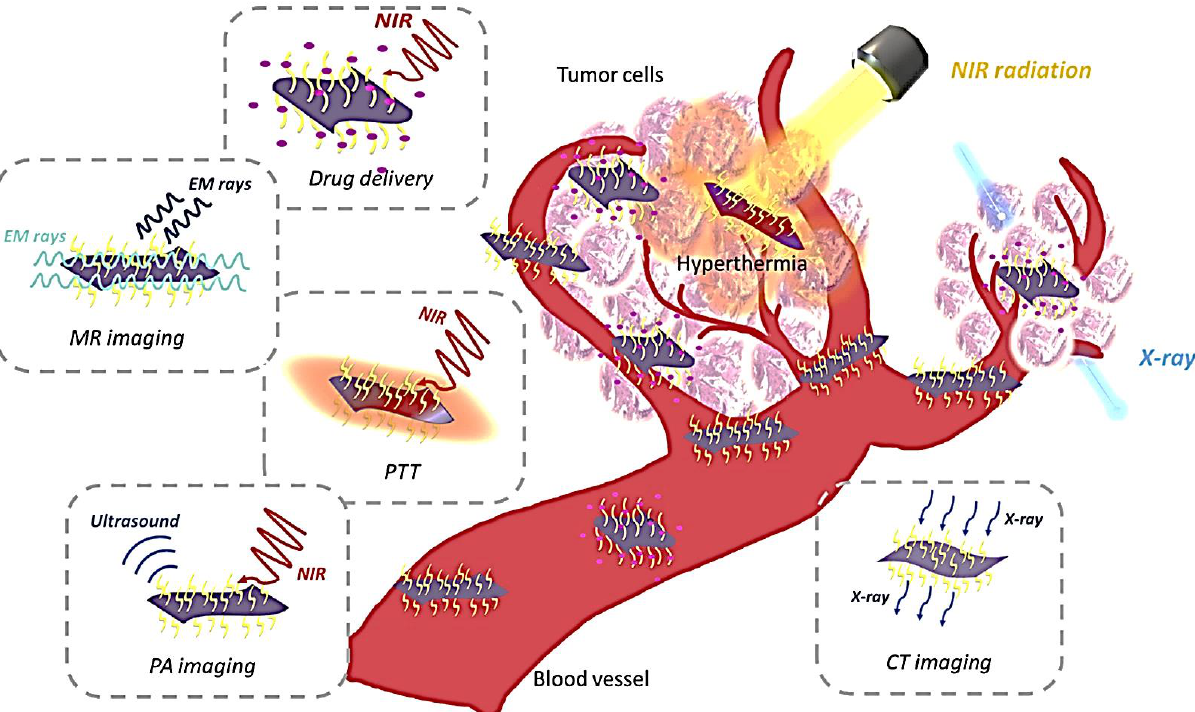
Figure 11. A sketch of PTT/chemotherapy [11]. Reprinted with permission from Ceramics Interna- tional. © 2019 Elsevier Ltd. and Techna Group S.r.l.